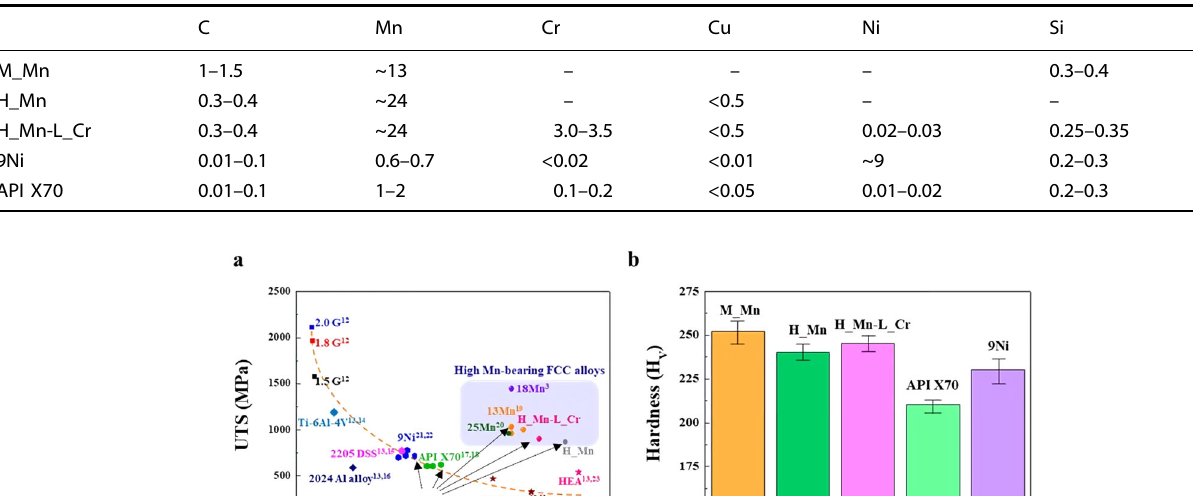
Table 1. Chemical composition of the tested samples (wt. %).